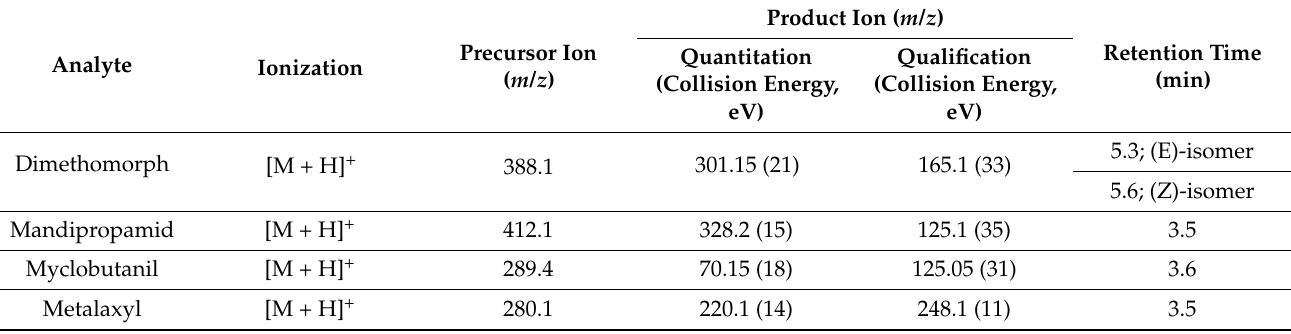
Table 1. Multiple reaction monitoring conditions of the four